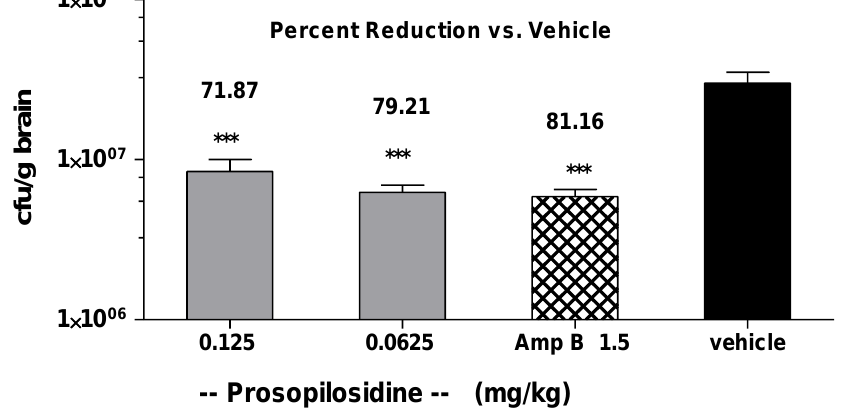
Figure 4. Cryptococcus neoformans infection in the mice treated with prosopilosidine administered bid . Graph showing live colony forming units (CFU) of C. neoformans per gram of brain tissue and percent reduction in infection by prosopilosidine treatment given at doses 0.06215 and 0.125 mg/kg body weight and amphotericin B (1.5 mg/kg body weight), as compared to the vehicle control. Amp B: Amphotericin B (1.5 mg/kg body weight). Data are shown as mean + SEM ( n = 5) and was analyzed with ANOVA. *** p < 0.001 was considered statistically significant compared to the vehicle control.